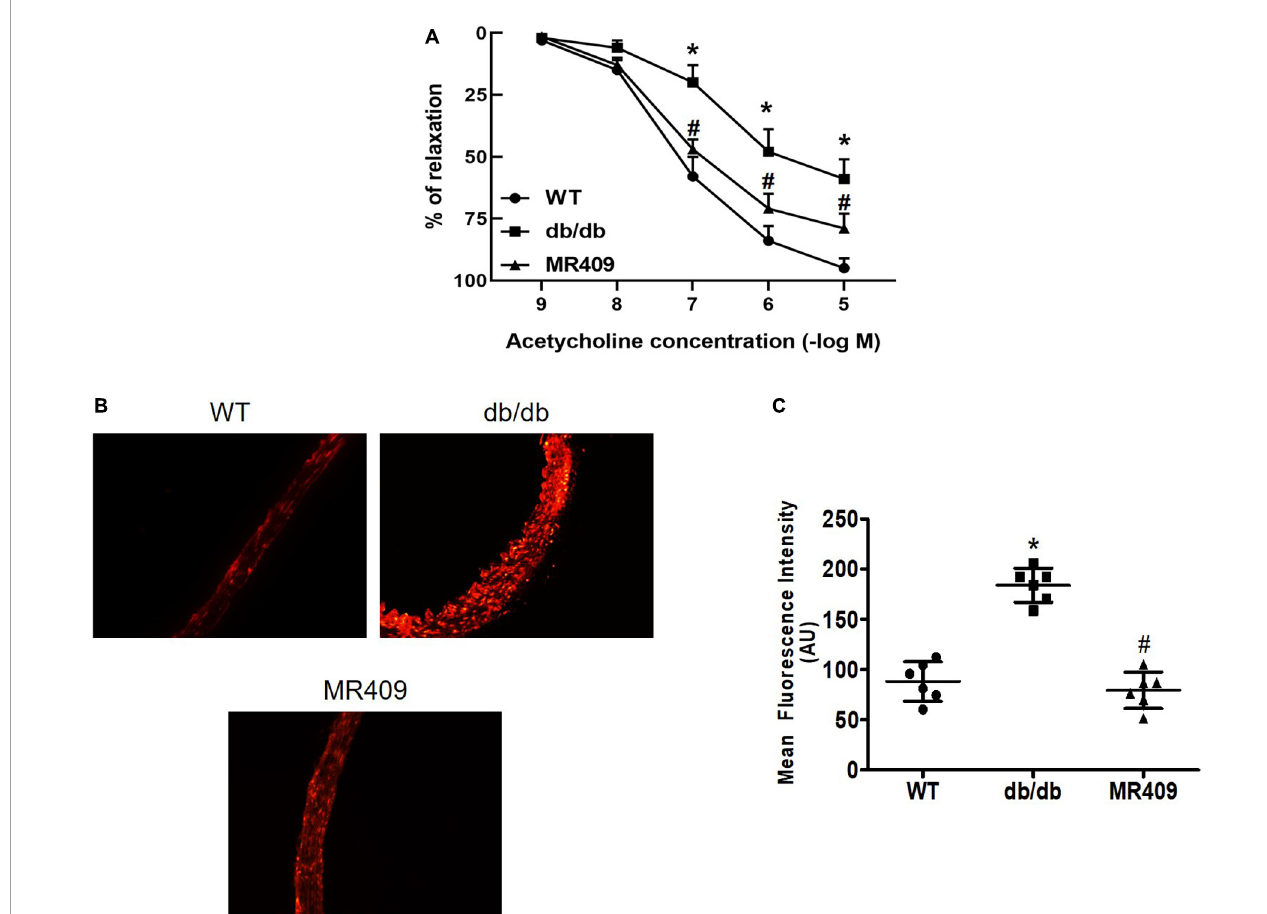
FIGURE3 Treatment with MR409 improves endothelium-dependent relaxation to acetylcholine (A) and reduced reactive oxygen species (ROS) production in the aorta of diabetic db/db mice. (B) The representative images of oxidative fluorescence intensities in the aorta, assessed by DHE fluorescence staining, (C) the quantification of average oxidative fluorescence intensities. N = 6, * p < 0.05 diabetic mice vs. WT mice, # p < 0.05 MR409 treated mice vs. diabetic mice.